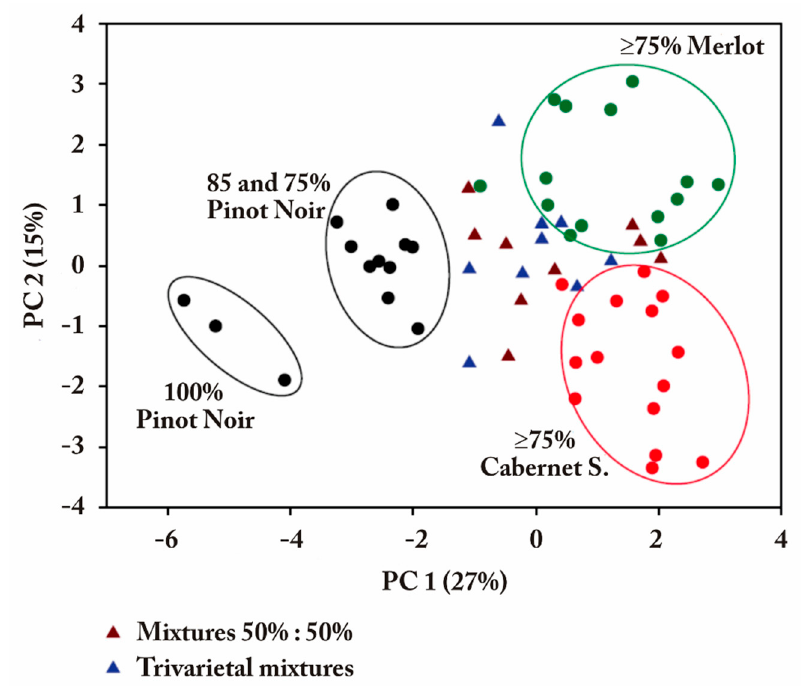
Figure 3. Representation of the principal components analysis (PCA) results for the 20 triplicate blends of Cabernet Sauvignon, Merlot, and Pinot Noir red wines [20].